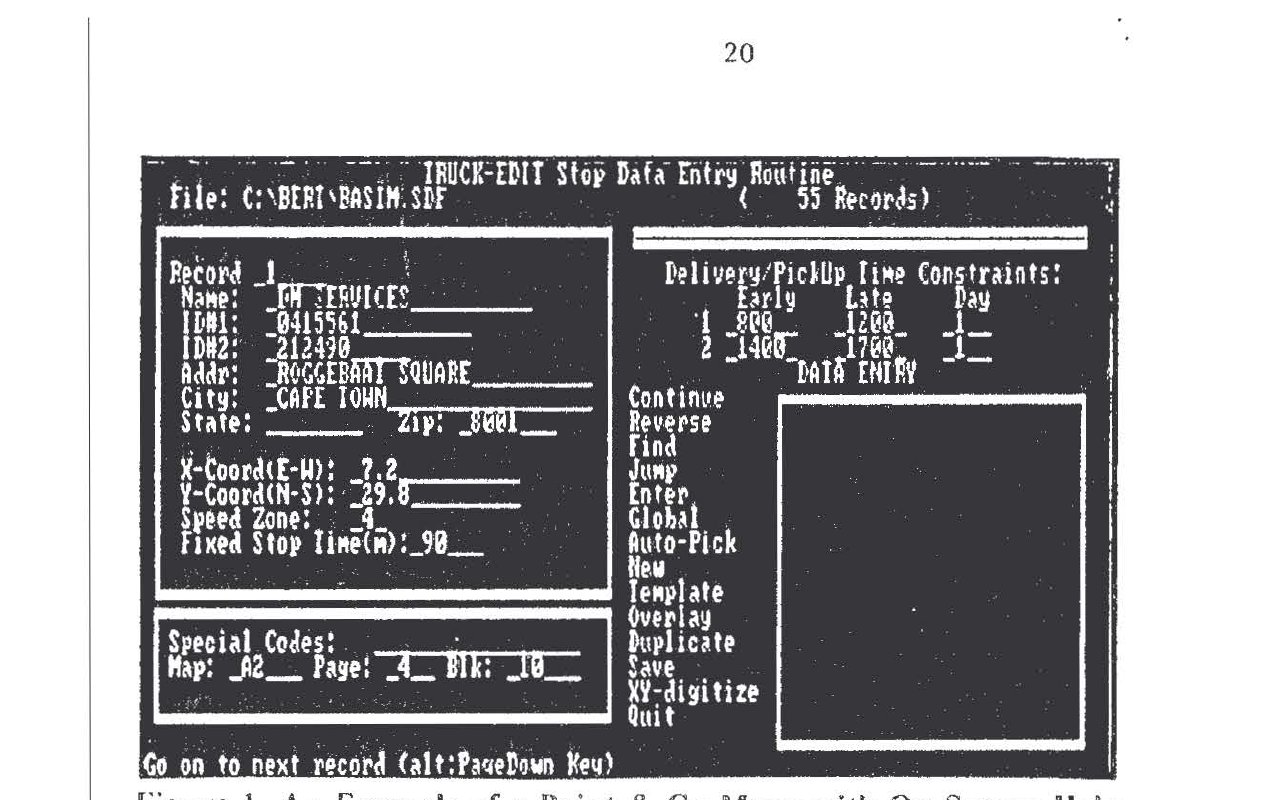
Figu1·c I An Example of a Point & Go Menu with On~Sct·cen llclp from the TRUCKSTOPS System (Source TruckStops 2 Manual).